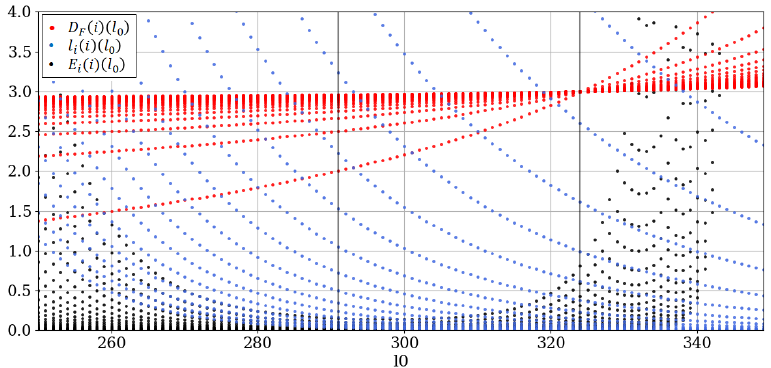
Figure 6. ( D F ( i ))( l 0 ) , ( l i ( i ))( l 0 ) , ( E i ( i ))( l 0 ) bifurcation maps: l 0 between 250 and 350 m, with a fixed l 1 = 200 m and l d = 0.008 m.